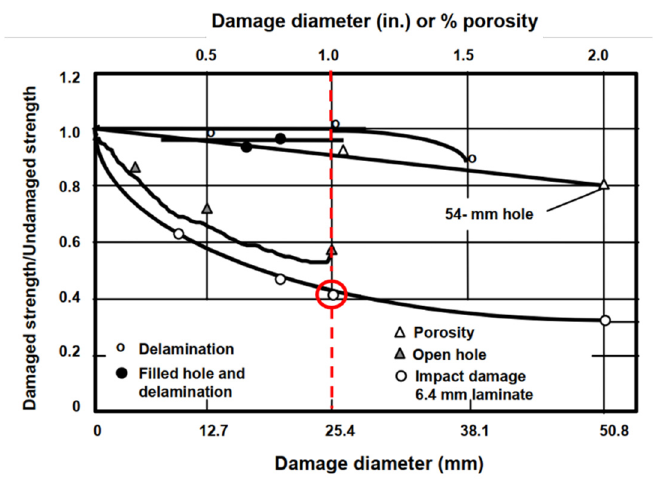
Figure 1. Remaining composite strength as a function of impact damage diameter [3].